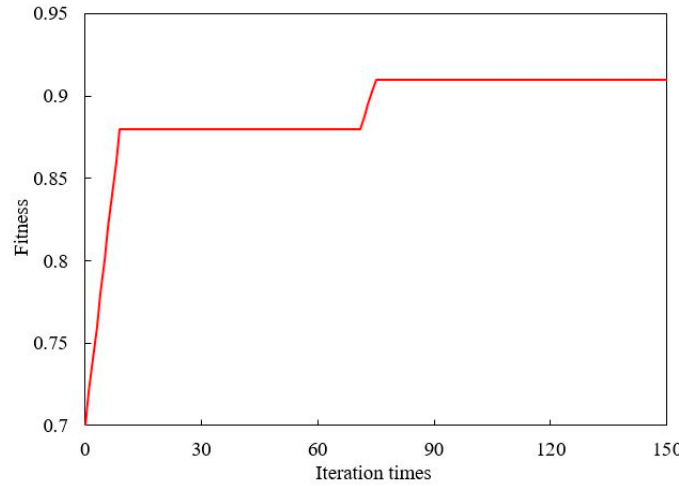
Figure 4. Fitness of solutions in the ABC-BP model.